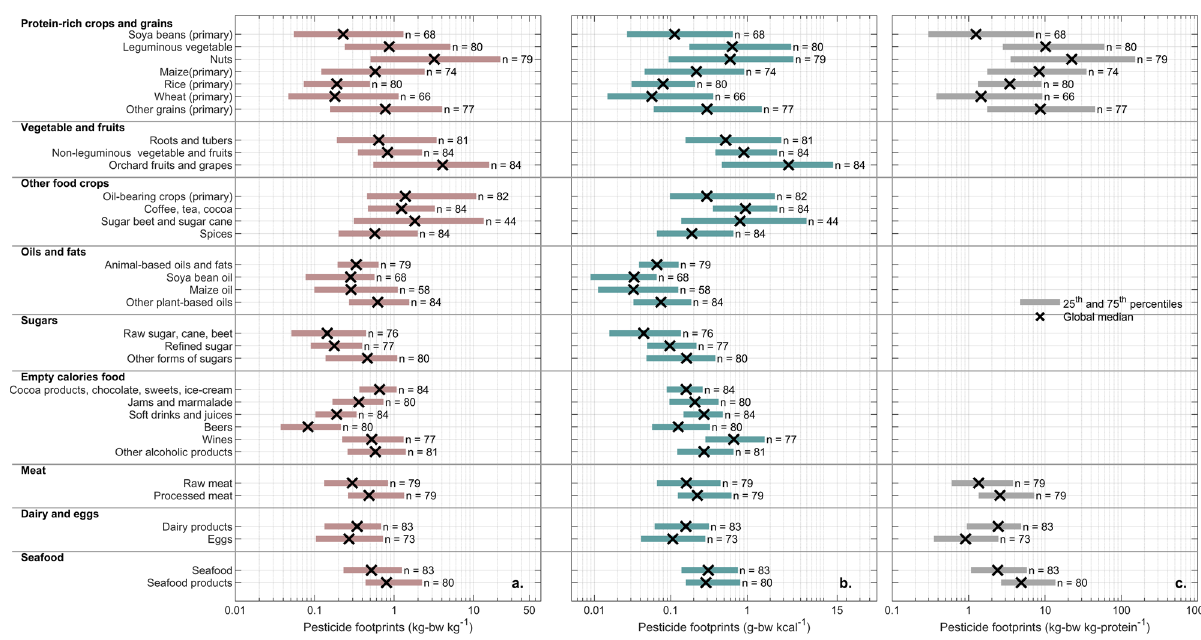
Fig. 5 Pesticide footprints embedded in food products. Footprints expressed as per kilogram food product ( a ), per kilocalories ( b ), and per kilogram protein ( c ). The bars show the 25th and 75th percentile values across different producing countries. The cross markers show the global median values. n represents the number of producing countries included. Footprints per kilogram protein are not represented for “ Vegetable and fruits ” , “ Other food crops ” , “ Oils and fats ” , “ Sugars ” , and “ Empty calories food ”